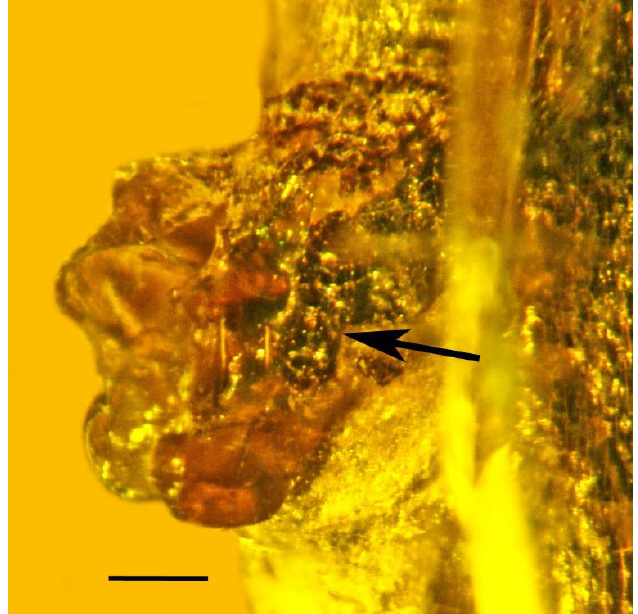
Figure 17. Detail of cocoons shown in Figure 16. Arrow shows mature wasp pupa or newly emerged adult. Scale bar = 280 µm.